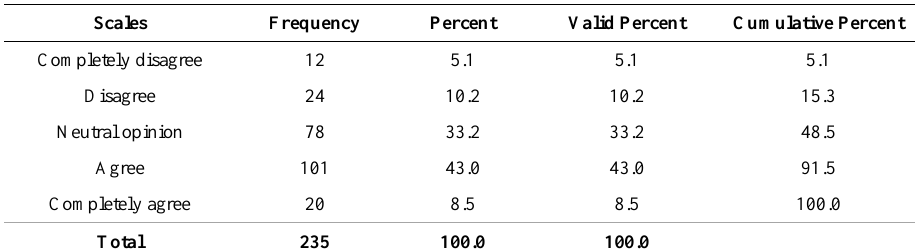
Table 1. Enterprises enhancing the business management capacity